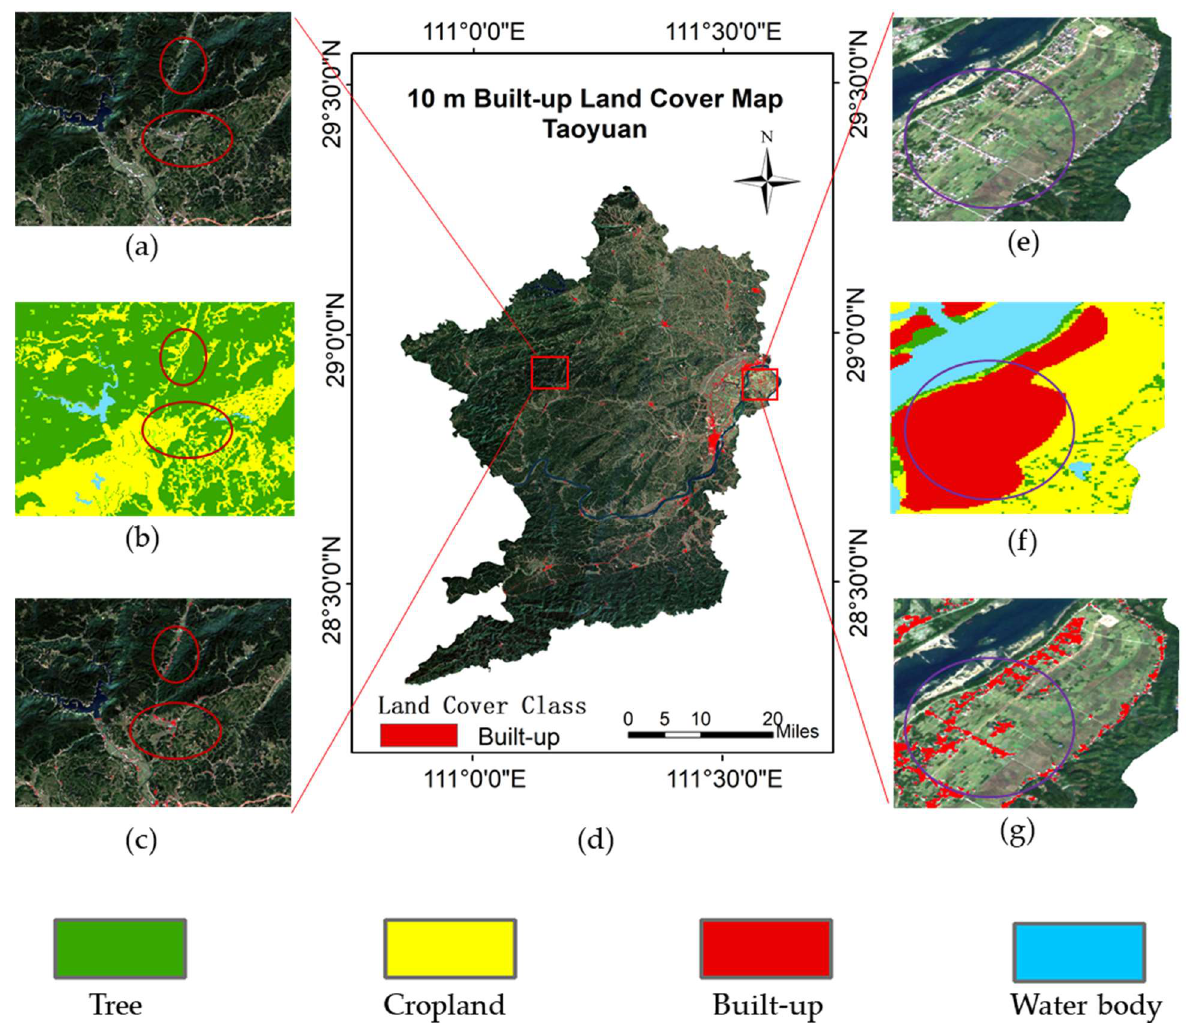
Figure 4. Build-up landcover mapping results. ( a ) Remote sensing imagery of small settlements. ( b ) The 30 m land cover map for small settlements. ( c ) Results of mapping of small settlements ( d ) The 10 m resolution build-up land mapping of Taoyuan County. ( e ) Remote sensing imagery of large settlements. ( f ) The 30 m land cover map for large settlements. ( g ) Results of mapping of large settlements.